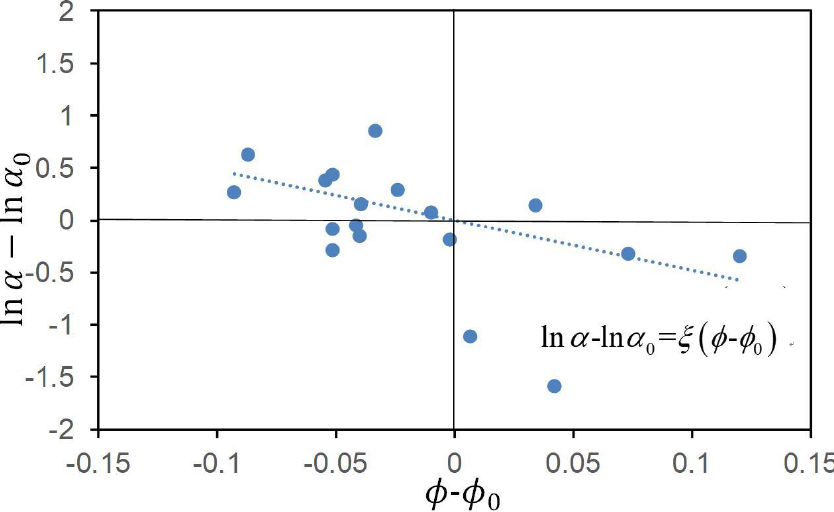
Figure 4. Effect of initial porosity on air-entry value: relationship between porosity variation and logarithm scale air-entry value difference.